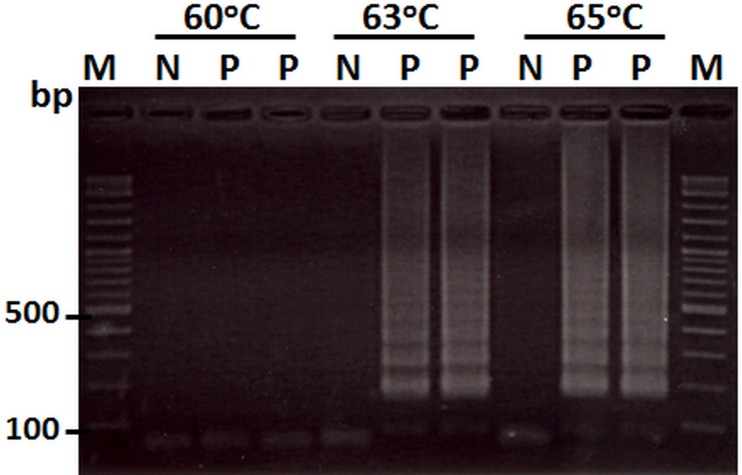
Optimization of the LAMP assay for detection of VPAHPND at different temperatures (60, 63 and 65°C) using 100 ng of DNA extracted from VPAHPND isolate 5HP in duplicate tests (Lane P).Lane M: 2 log DNA marker, Lane N: 100 ng of DNA extracted from healthy P. monodon (negative control).